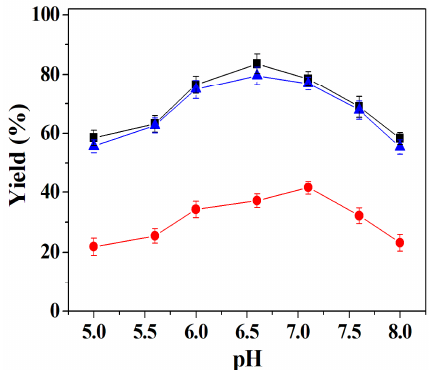
Figure 4. Effect of pH on the yield of DFF of co-immobilized tri-enzymes ( ■ ), separately immobilized tri-enzymes ( ▲ ), and free tri-enzymes ( ● ). Reaction conditions: 35 mg of co-immobilized tri-enzymes or 105 mg of separately immobilized tri-enzymes (containing 35 mg of immobilized galactose oxidase, 35 mg of immobilized catalase and 35 mg of immobilized horseradish peroxidase) or free tri-enzymes (20 U of galactose oxidase, 8000 U of catalase and 500 U of horseradish peroxidase); 200 mM of HMF; 25 °C; at different pH values ranging from 5.0 to 8.0. The buffers used were citric acid–sodium citrate (pH 5.0–6.6), and Tris-HCl (pH 7.1–8.0), respectively.